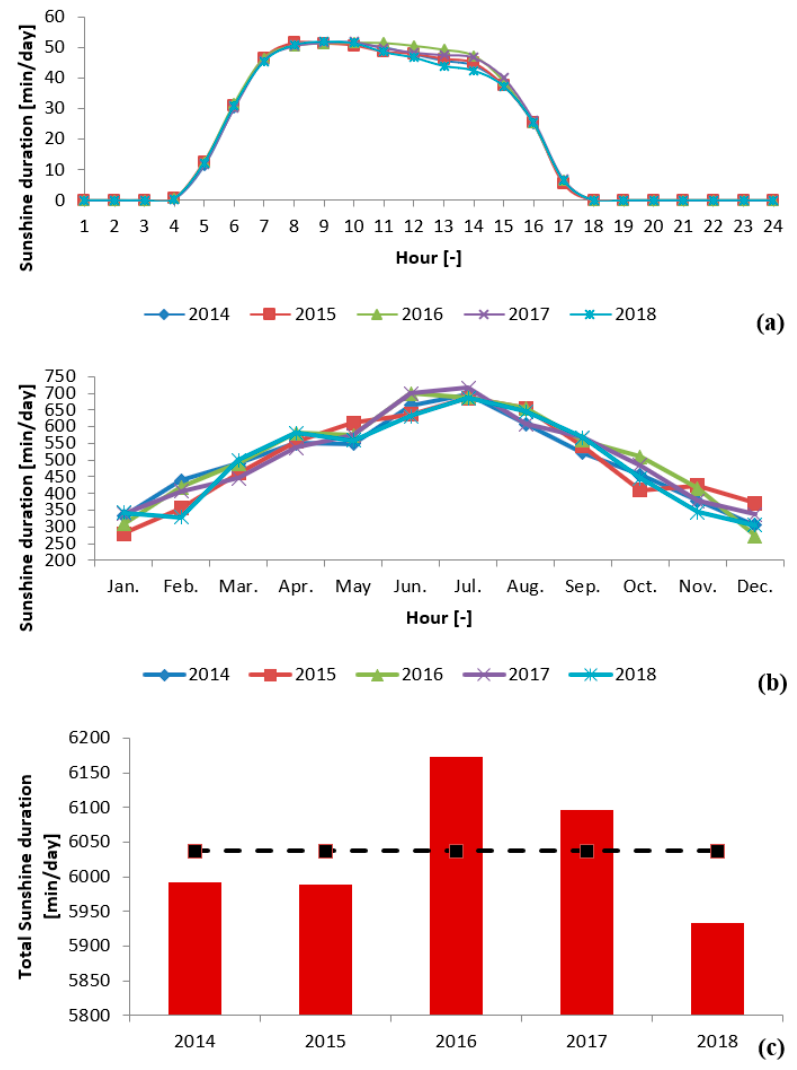
Figure 5. Sunshine duration; ( a ) hourly, ( b ) monthly, and ( c ) annual during the period of 2014–2018.